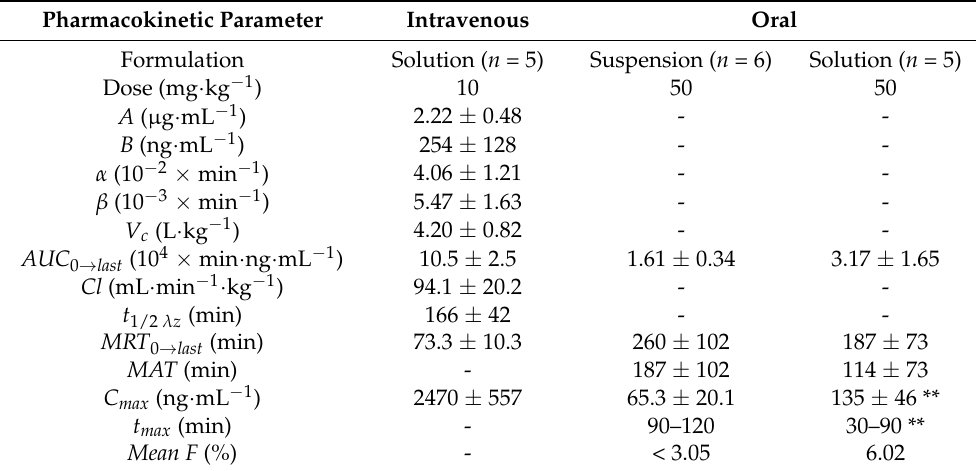
Table 3. Pharmacokinetic parameters of tangeretin (TAN) a